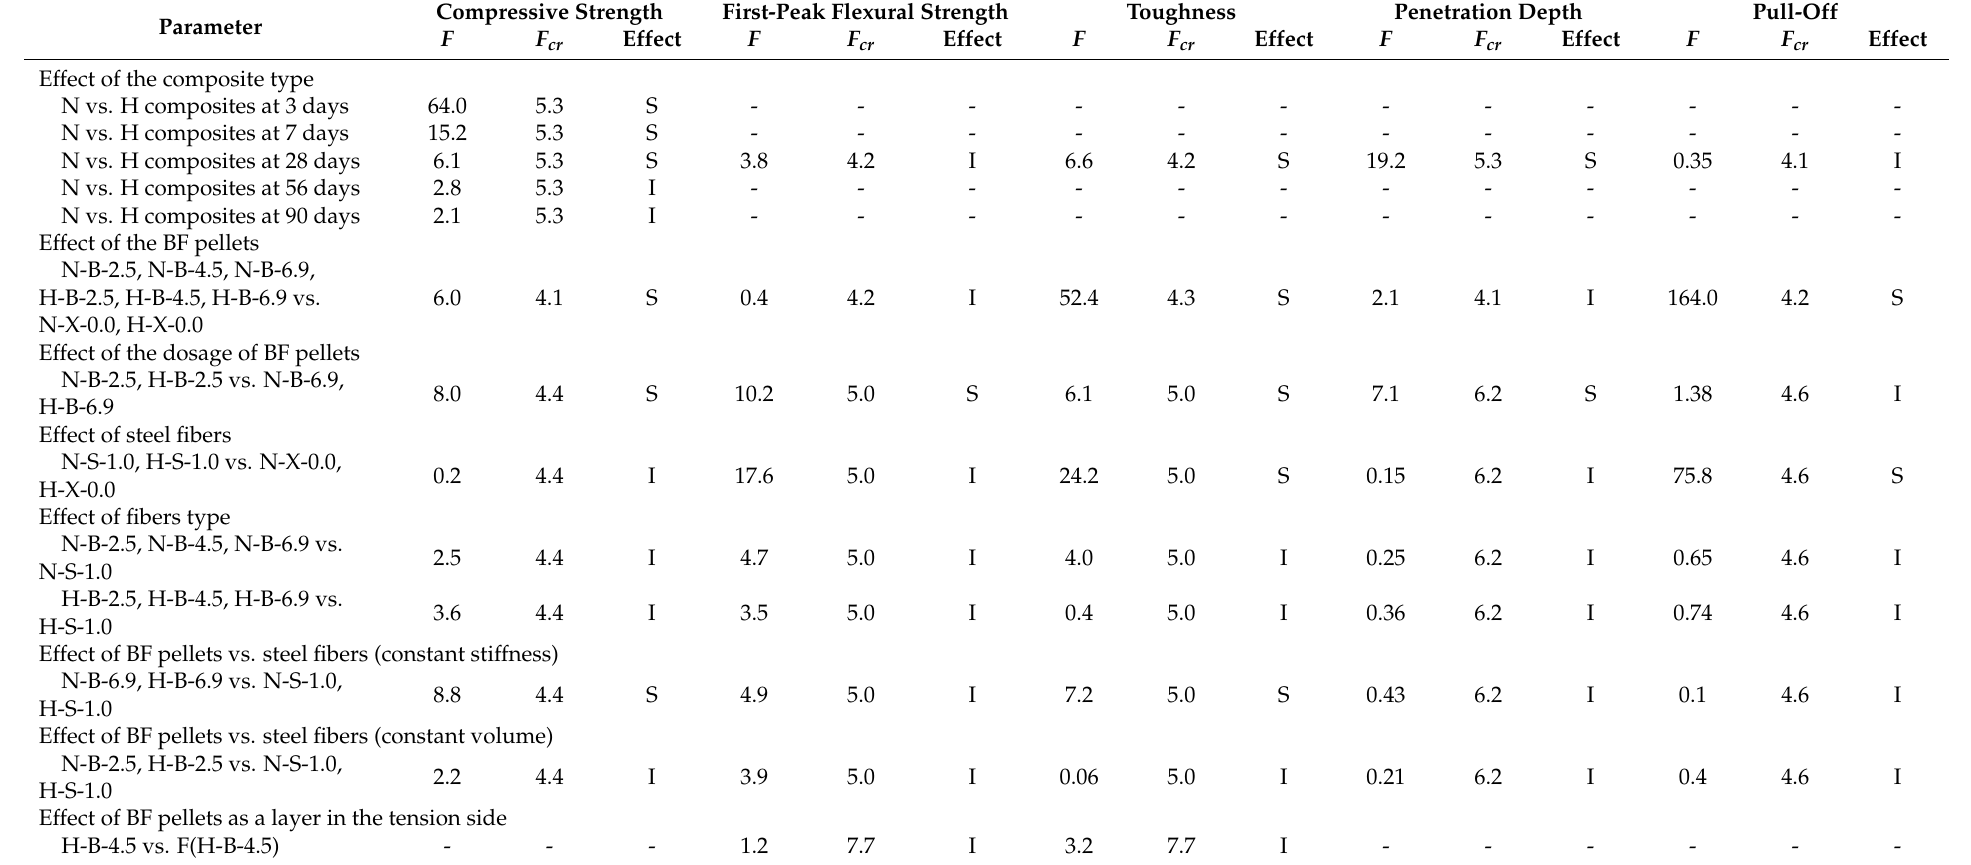
Table 6. ANOVA for the results of compressive strength, flexural strength, and toughness at 28